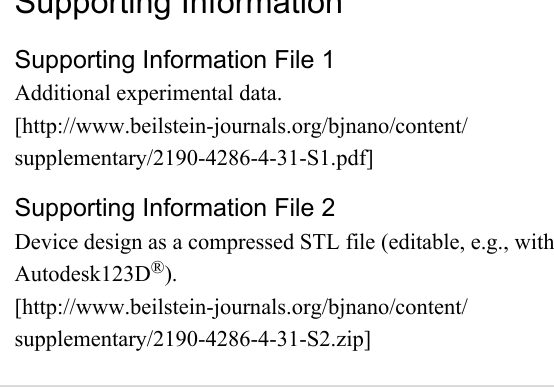
For the relative intensity of the [Ni(C 24 H 24 N 6 )(NO 3 )] + ( 2 ), m / z 516.1 and [Cu(C 24 H 24 N 6 )(NO 3 )] + ( 1 ), m / z 521.1 species see Supporting Information File